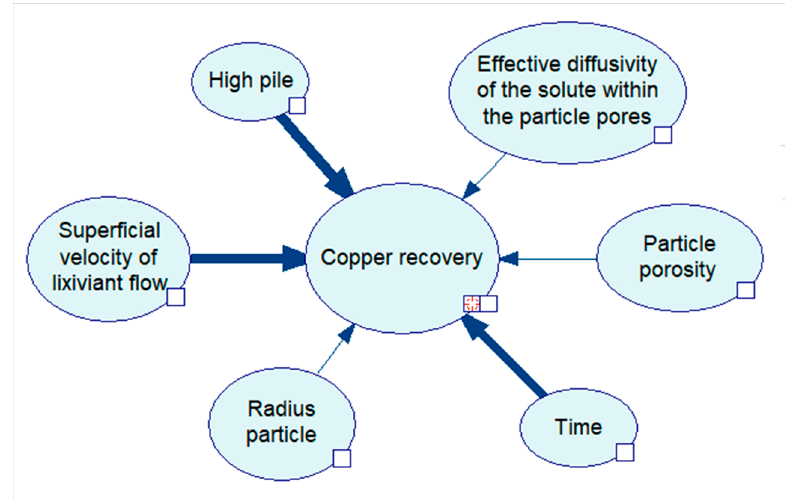
Figure 4. Bayesian network for copper heap leaching process.